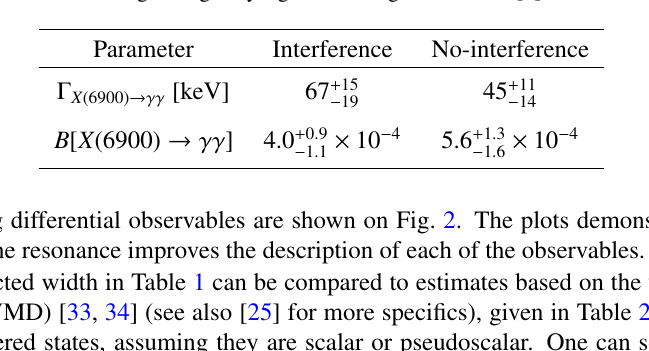
Table 1. The two-photon width and the corresponding branching ratio of X(6900) obtained in [25] by fitting the light-by-light scattering data of Ref.